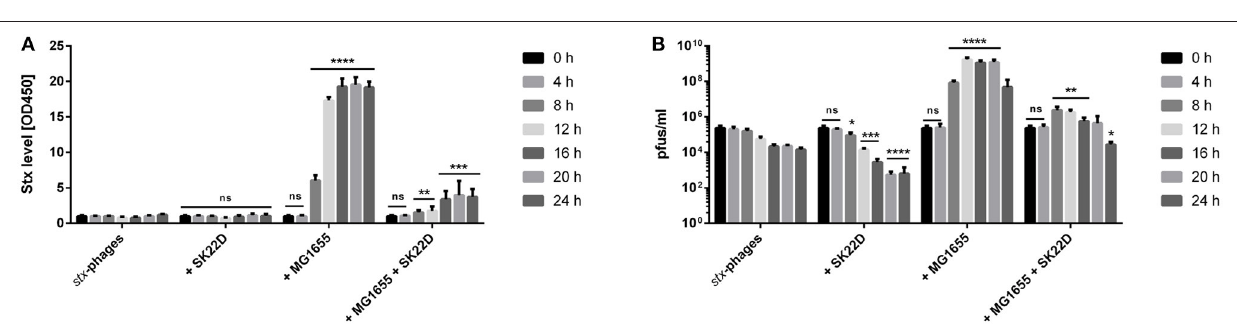
FIGURE 6 | Protection of K-12 strain lambdoid phage infection by SK22D. Lambda-phages (A) or stx -phages (B) were incubated in mono-/co-/or tricultures with the microcin negative EcN strain SK22D and/or the K-12 strains MG1655, HB101 or DH5 α at a starting MOI of 1:10:10 for 24 h, static. Afterwards, the pfus/ml were determined in the sterile filtrate with a Phage Plaque Assay (PPA). 24 h pfus/ml for HB101/ DH5 α + SK22D + stx -phages: 0 pfus/ml (C) In case of the stx -phage experiment the Stx level of the filtrate was determined with the Ridascreen ® Verotoxin Elisa. Lambda-phages (D) or stx -phages (E) were incubated in mono-/co-/or tricultures with SK22D, the commensal control strains SE15, IAI1 and MG1655 at a starting MOI of 1:10:10 for 24 h, static before the pfus/ml were determined with the PPA. LB Medium was used as negative control. ns, not significant, * p < 0.05, ** p < 0.01, *** p < 0.001, and **** p < 0.0001.